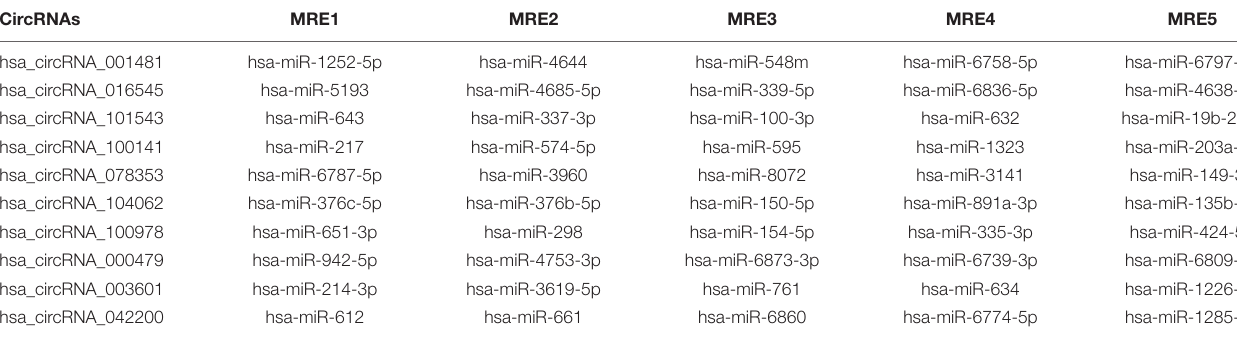
TABLE 3 | Top five miRNA binding sites of top differentially expressed circRNAs.